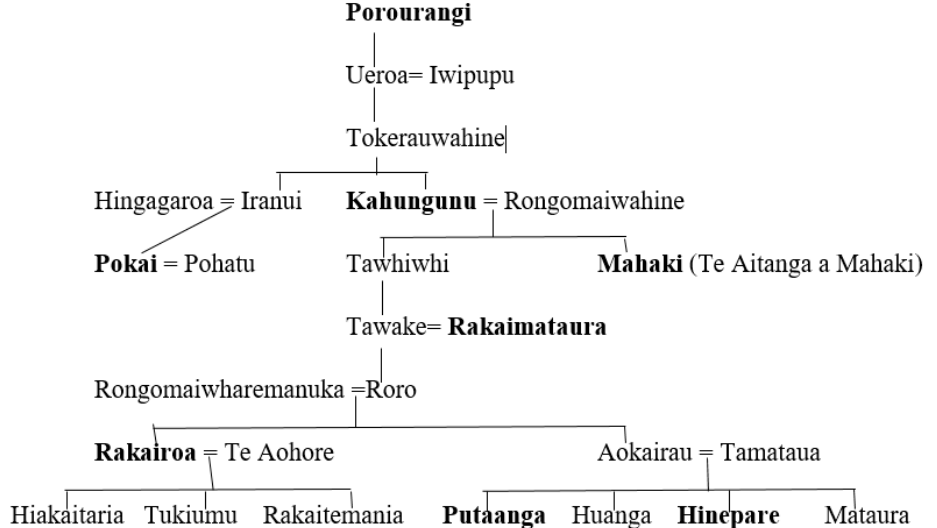
Figure 1. Whakapapa Chart 1.